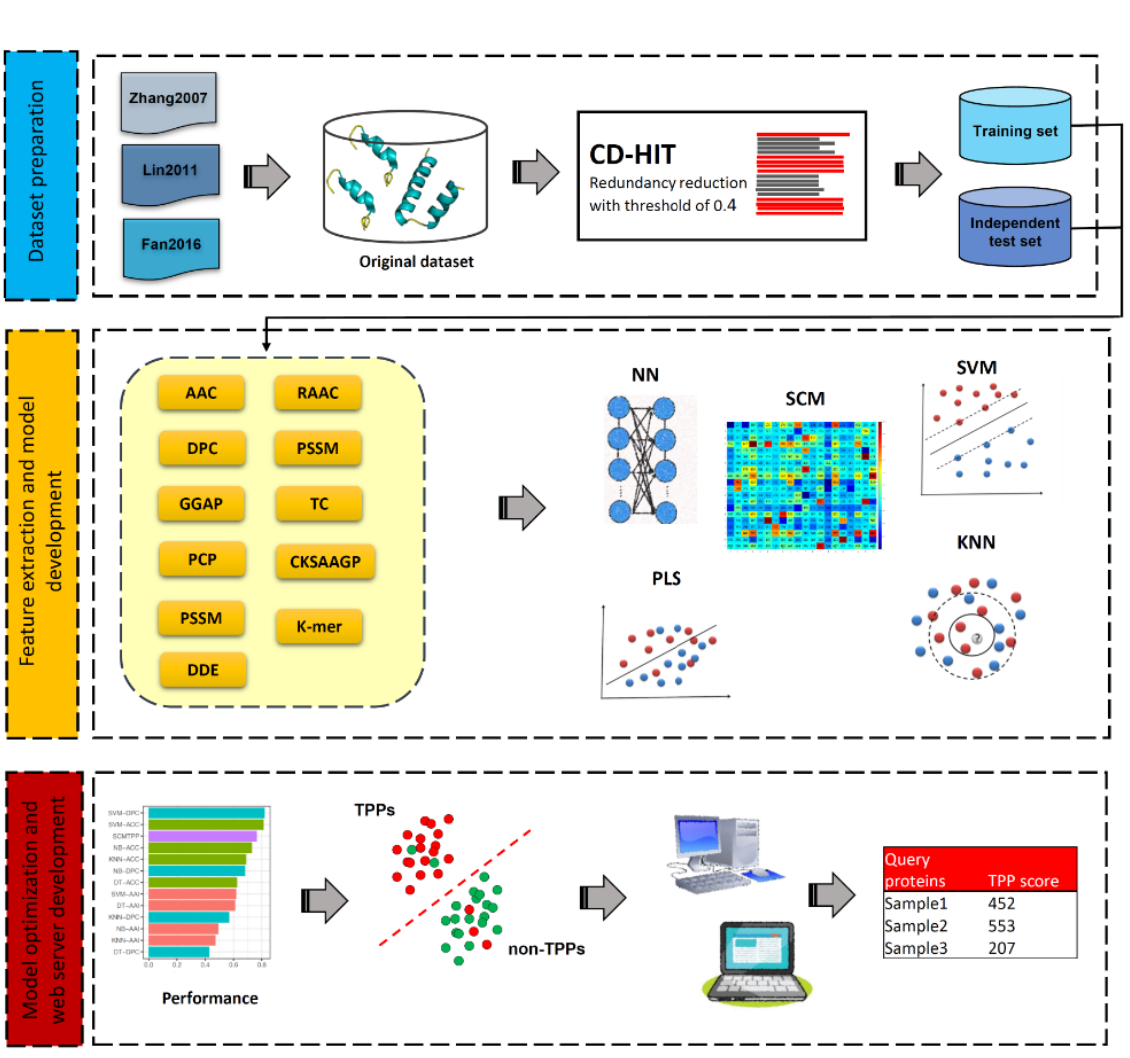
Figure 1: The overall framework of TPP predictors using machine learning methods. The 1st phase is dataset preparation to form training and independent datasets. The 2nd phase is feature extraction and feature optimization. The 3rd phase is to train and evaluate a prediction model. The independent dataset is used to validate the effectiveness and robustness of the prediction model. Finally, the optimal predic- tion model is selected to establish a web